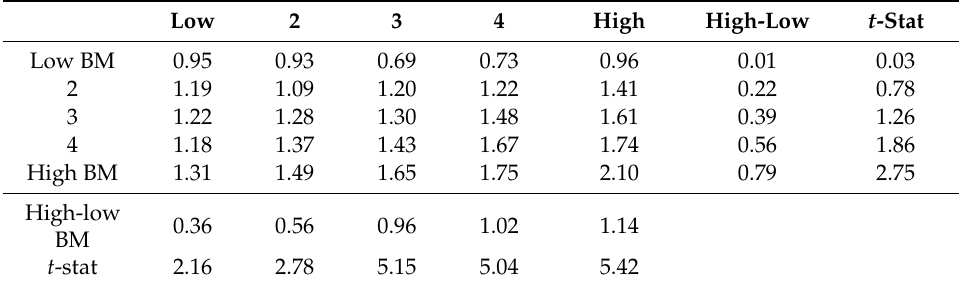
Table 13. Average returns from double-sorted quantile portfolios (sorted by book-to-market ratio and Geske’s total default probability). From the data for July 1963 to December 2013, at the end of each month, stocks are independently sorted into 5 × 5 portfolios based on the book-to-market ratio and Geske’s total default probability. The table shows average returns for each of 25 portfolios. Small-big is the return di ff erential between the small and big firm portfolios within each default quantile. High-low is the return di ff erential between the high and low default probability firms within each size quantile. t -statistics are calculated using Newey-West standard